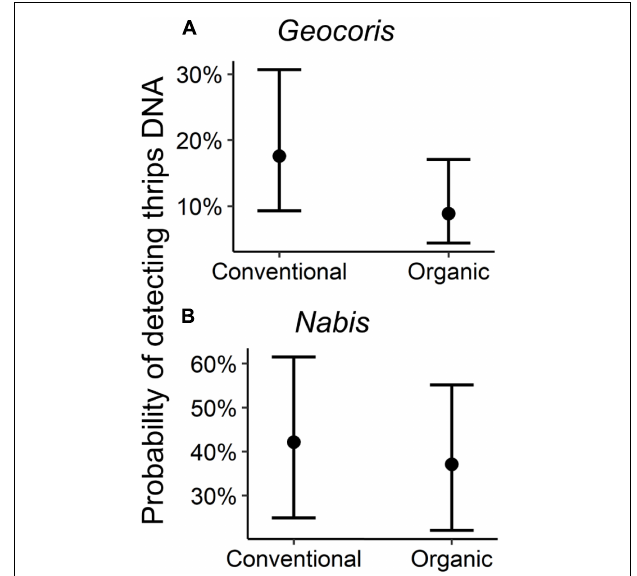
FIGURE 1 | Probability of detection of western flower thrips DNA in (A) Geocoris and (B) Nabis by farming system. Figure shows the predicted values from the models including farming system alone using the “plot_model” function in the sjPlot package in R. Bars show 95% confidence interval.